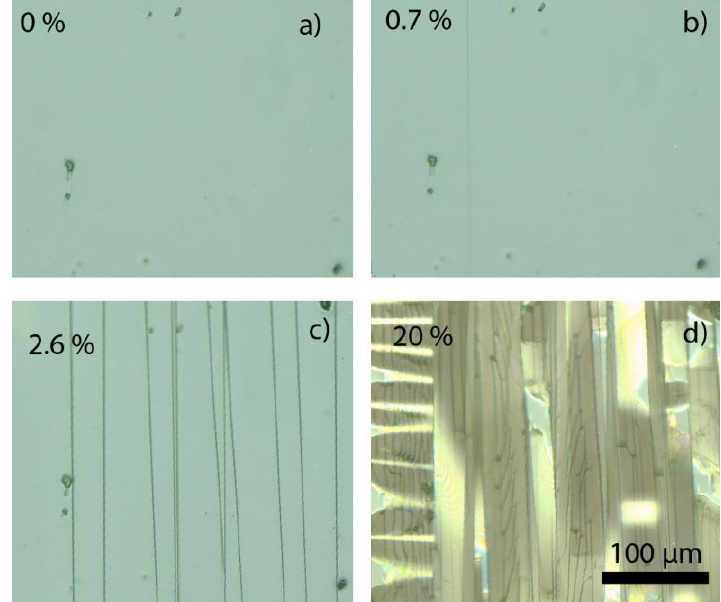
Figure 3. Optical microscope images of 240 nm thick Al 2 O 3 /ZnO nanolaminate with 4.8 nm bilayer thickness during tensile strain experiment (tensile strain is applied horizontally in these images). Note the increasing density of cracks from ( a ) to ( c ) and then the development of buckles and delamination of the film (bright shiny features) from the substrate in ( d ). Cracks in the sub-surface growth material can also be seen in ( d ); compare to Figure 6b.